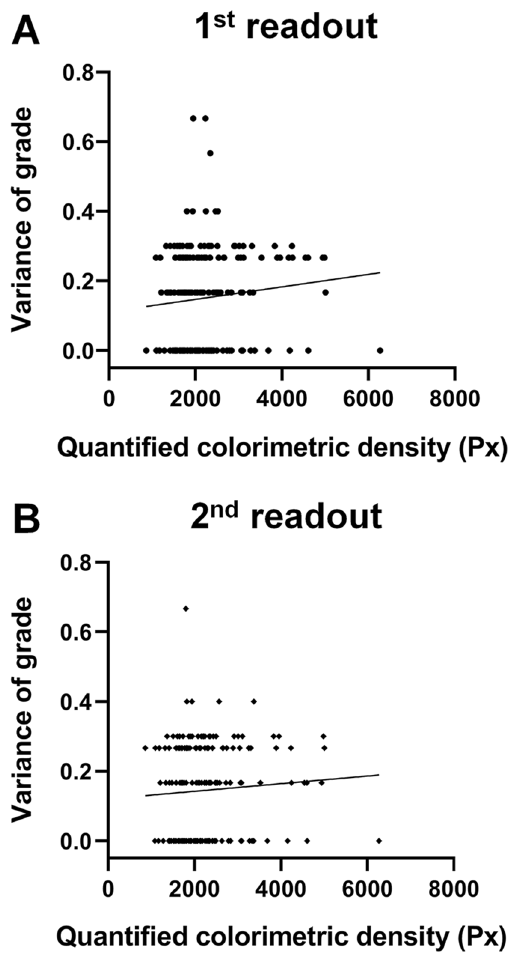
Figure 1. Scatterplots showing the relationship between the variance and the quantified colorimetric densities of the red band of the point-of-care matrix metalloproteinase (MMP)-9 immunoassay at both 1st readout and 2nd readouts. The correlation was not statistically significant at both readouts ( R 2 = 0.011 and P = 0.132 in A , R 2 = 0.005 and P = 0.321 in B